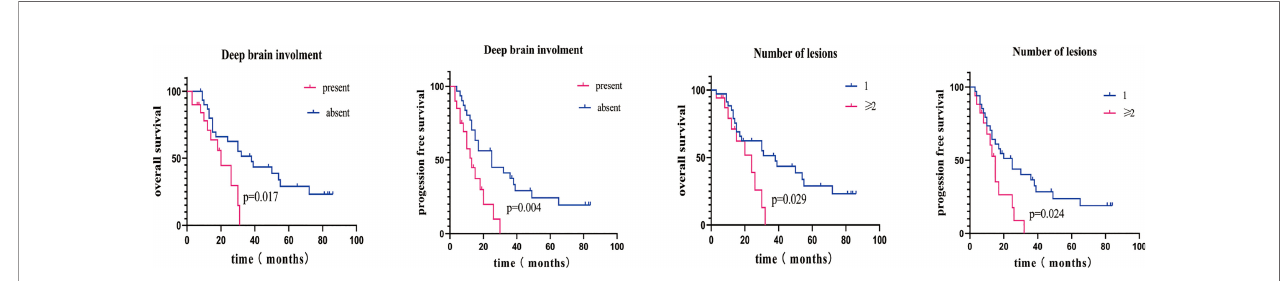
FIGURE 4 | Kaplan – Meier overall survival curve strati fi ed by various risk factors. (A, B) OS and PFS in patients with deep brain involvement (red line) or absent deep brain involvement (blue line). (C, D) OS/PFS in patients with multifocal lesions (red line) or one lesion